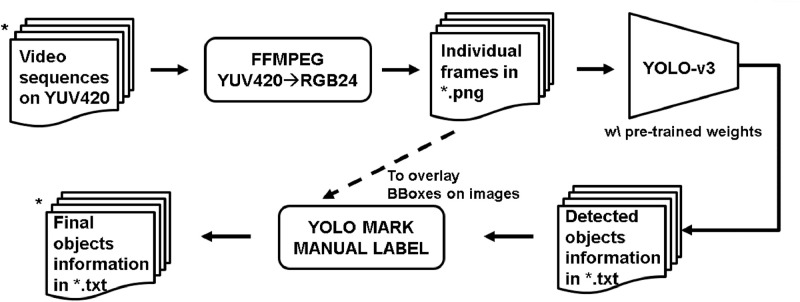
Labeling process.